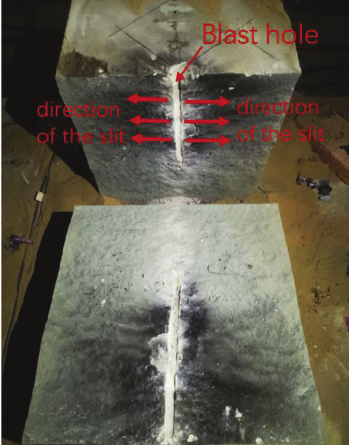
Figure 2: Blasting test results.